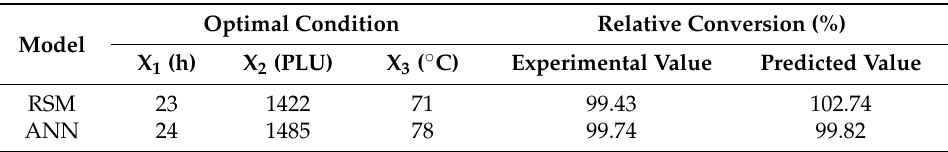
Table 4. The optimal trial obtained from RSM and ANN models.